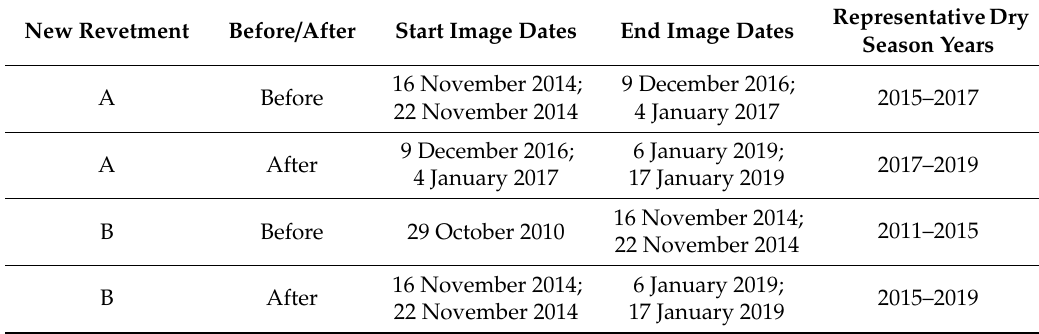
Table 6. Planet Lab imagery used to estimate End Point Rate (EPR) before and after installation of